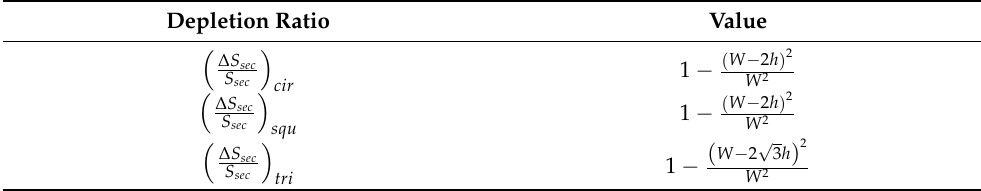
Table 3. The depletion ratio of three kinds of SiNWs-FET sensors. Depletion